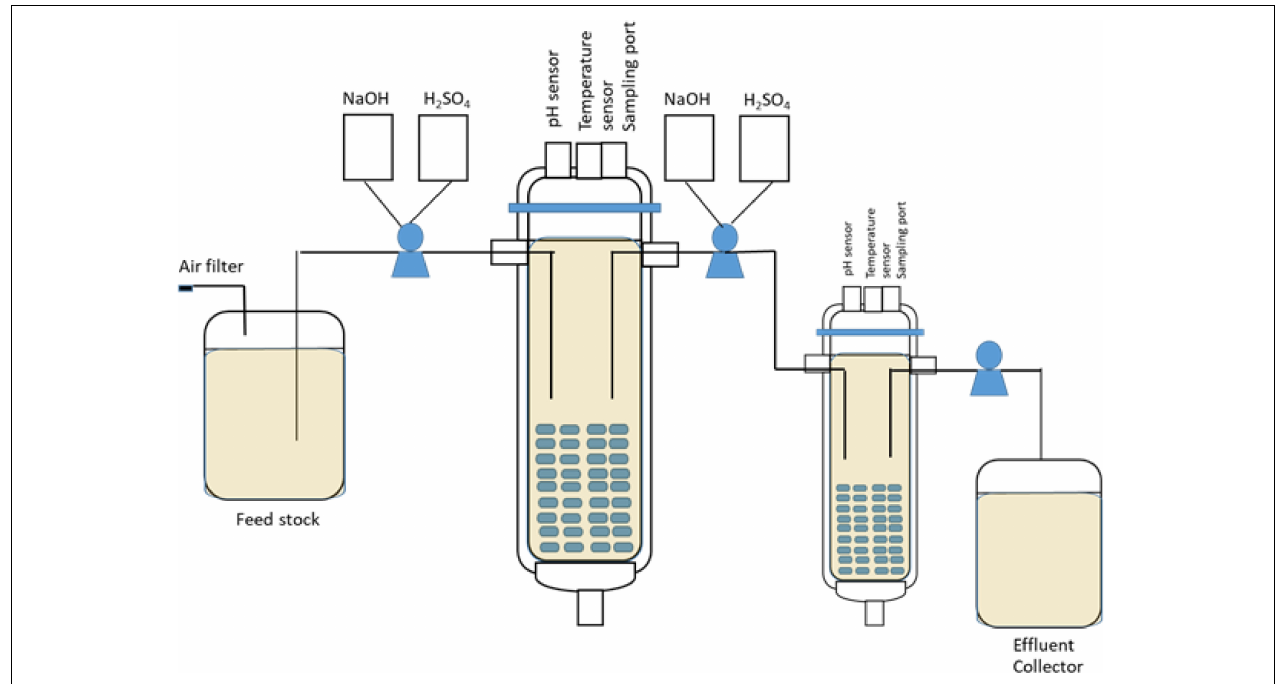
FIGURE 1 | Schematic diagram of the experimental setup of Z. mobilis biofilm reactor under the multistage continuous process.